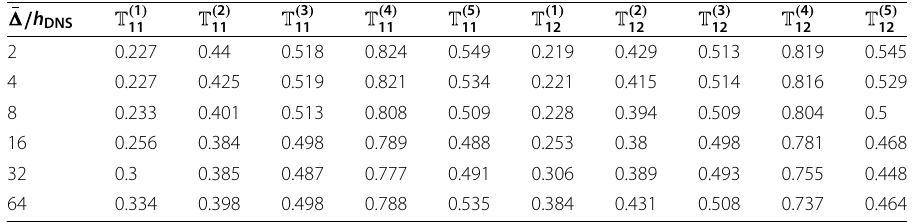
, A with the increasing of the filter ij ij